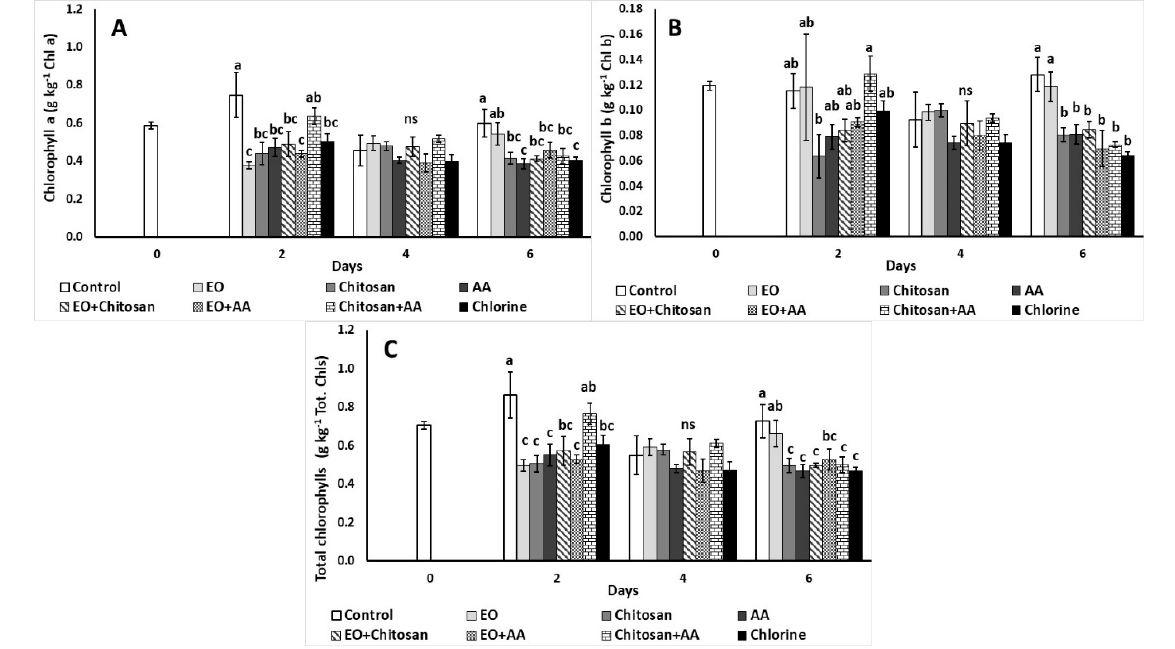
Figure 4. Effect of marjoram essential oil (EO), chitosan and ascorbic acid (AA) on fresh-cut lettuce ( A ) chlorophyll a (g kg − 1 ), ( B ) chlorophyll b (g kg − 1 ), and ( C ) total chlorophyll (g kg − 1 ) content after treatment and 6 days of storage at 7 °C and 90% RH. On the columns, significant differences ( p < 0.05) among treatments are indicated by different Latin letters; ns indicates no significant differences for different days. Values represent means (±SE) of measurements made on three biological replicates per treatment.